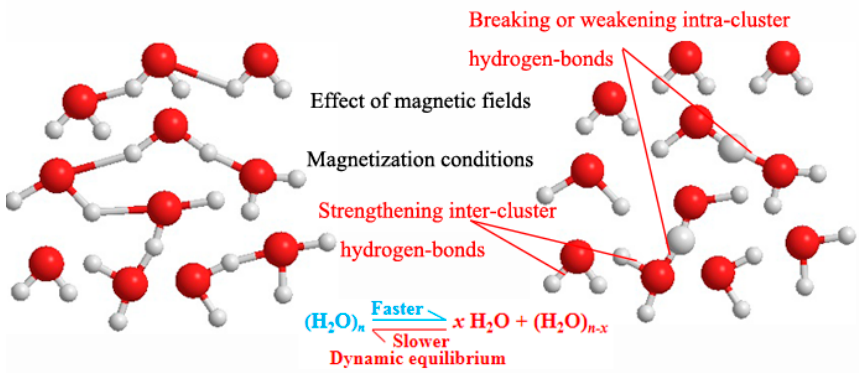
Figure 9. The effect of the magnetic field on water.